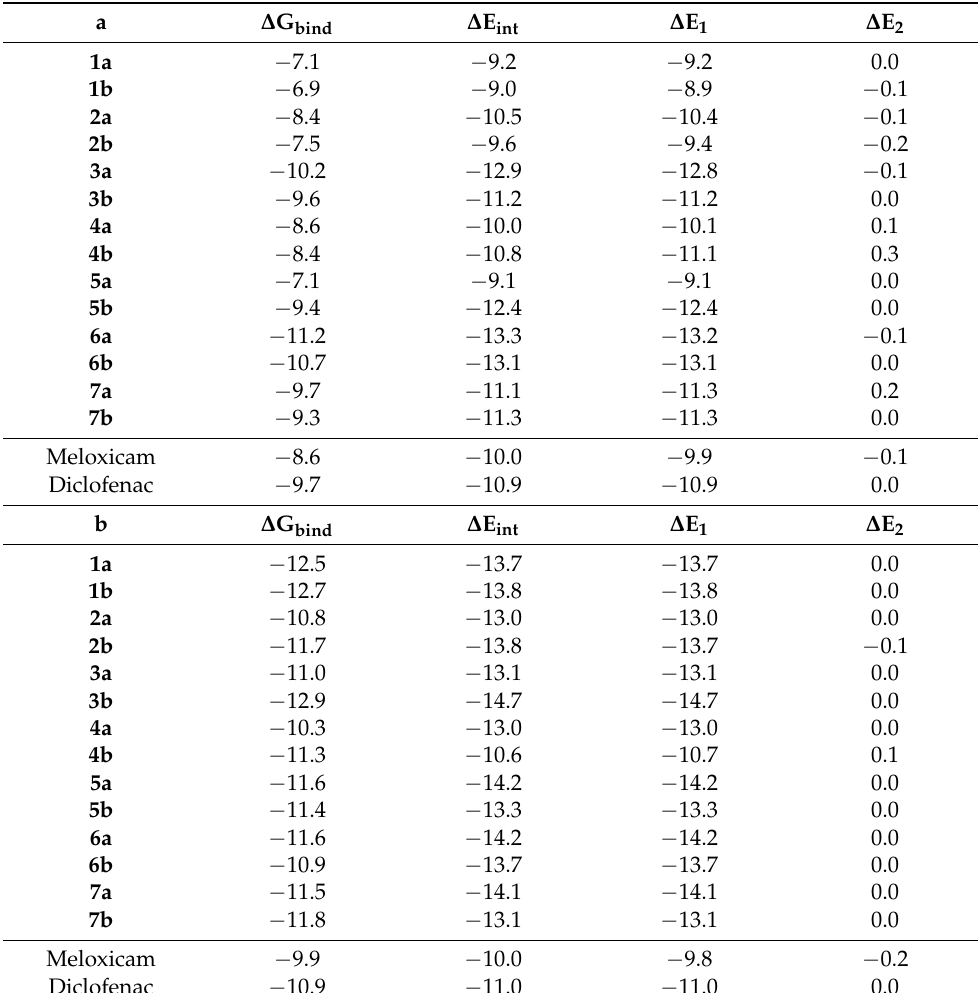
Table 2. Binding energies of designed compounds to (a) COX-1 and (b) COX-2 obtained from molecular docking ( ∆ G bind —free energy of binding; ∆ E int —intermolecular interaction energy; ∆ E 1